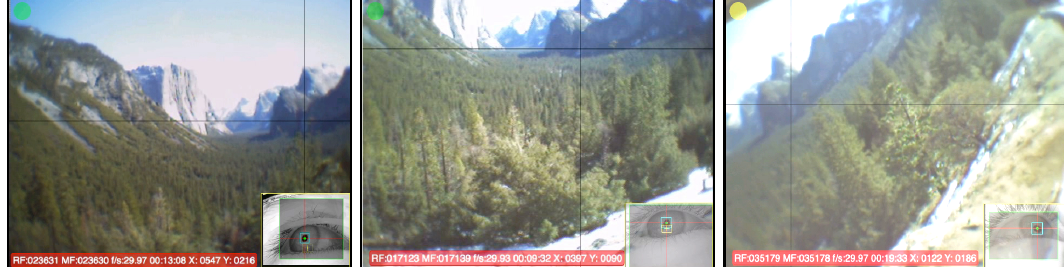
Figure 16. Lack of correspondence between fixated object and its location in the scene video. In each of the above frames, the observer is fixating the same feature (a hanging valley), but head movements and the different positions of each observers cause the feature’s location in the scene video to